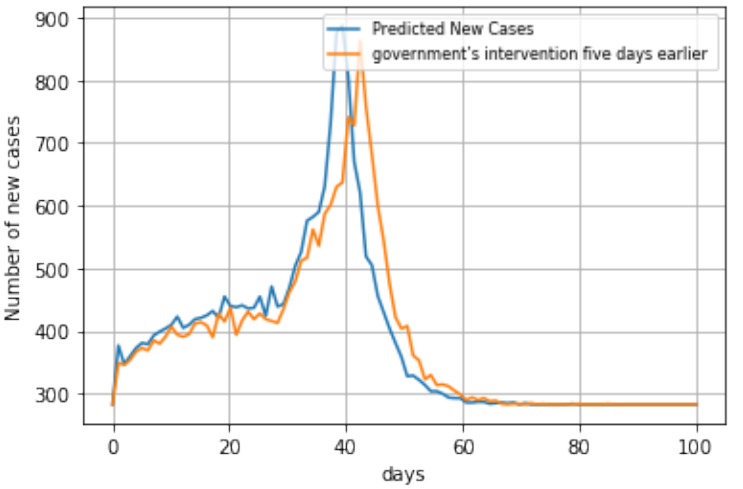
Figure 10. Predicted New Cases if the Government interventions were 5 days earlier.